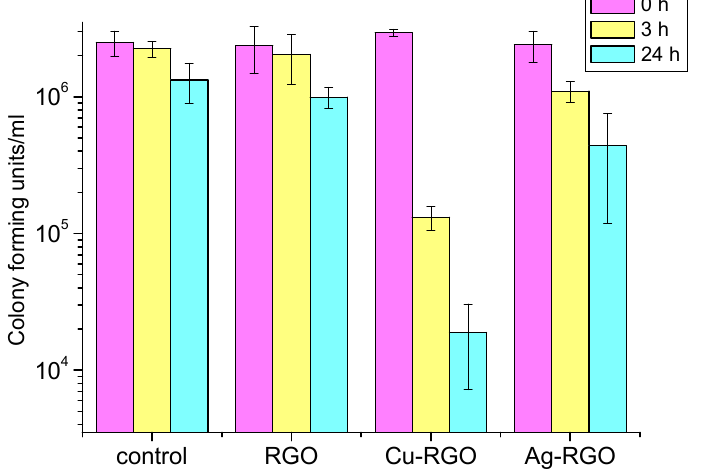
Figure 9. Survival of Escherichia coli bacteria after 0, 3 and 24 h treatment with RGO and metal–RGO composites.